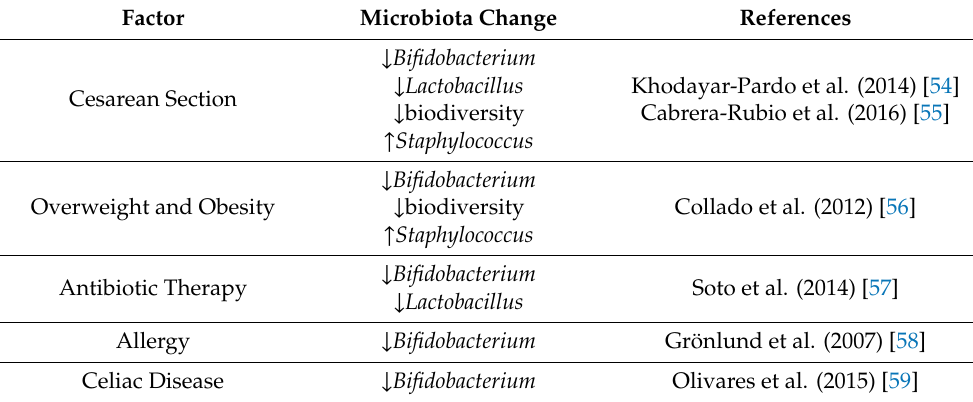
Table 3. Maternal factors influencing the composition of breast milk